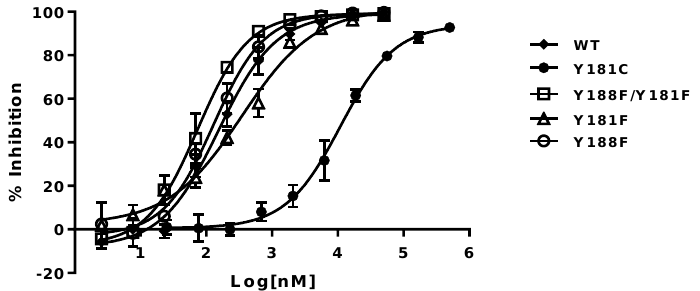
Figure 3. Inhibition curves of nevirapine (NVP) against Y181 and Y188 RT variants. The error bars are in means ± standard deviation with more than three replicates.